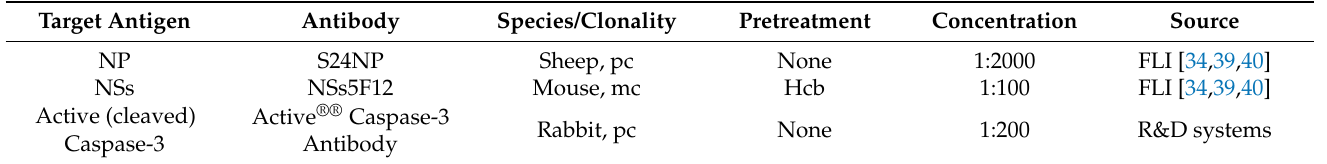
Table 2. Primary antibodies used for immunohistochemistry and